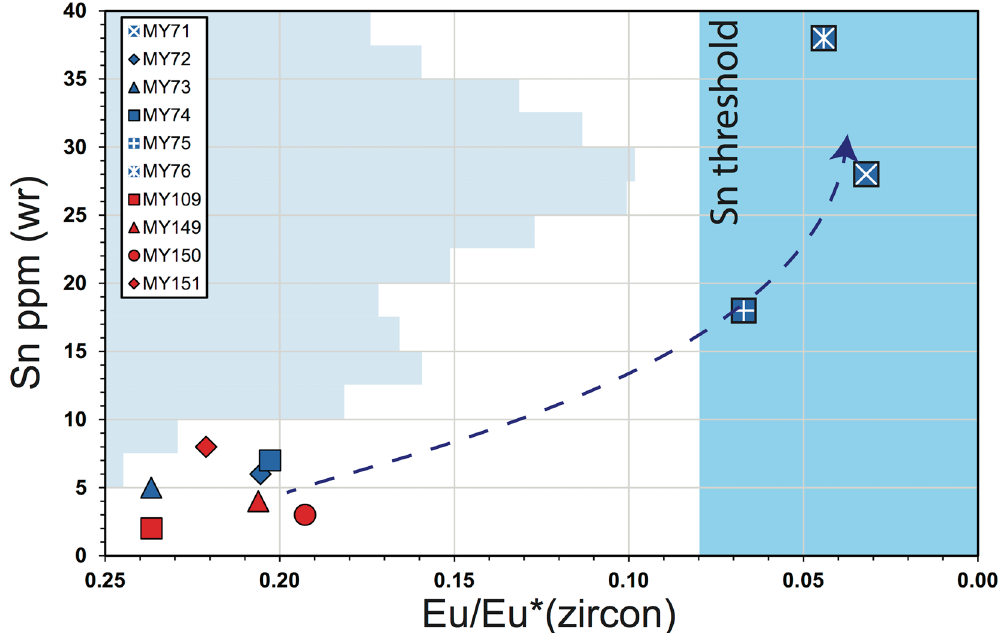
Figure 5. Plot of whole rock Sn content (ppm) against zircon Eu/Eu * . Blue shading represents a “threshold” level of Sn, suggesting a zircon Eu/Eu * of 0.08 or less may indicate elevated Sn values and the potential for the development of tin mineralization. Also plotted on the y-axis are aggregated and bucketed whole-rock Sn contents reported for major tin deposits from Southeast Asia (Malaysia and Thailand), the Erzgebirge, Bolivia, Portugal, Nigeria, and the Massif Central, as summarized in Lehmann (1990) 19